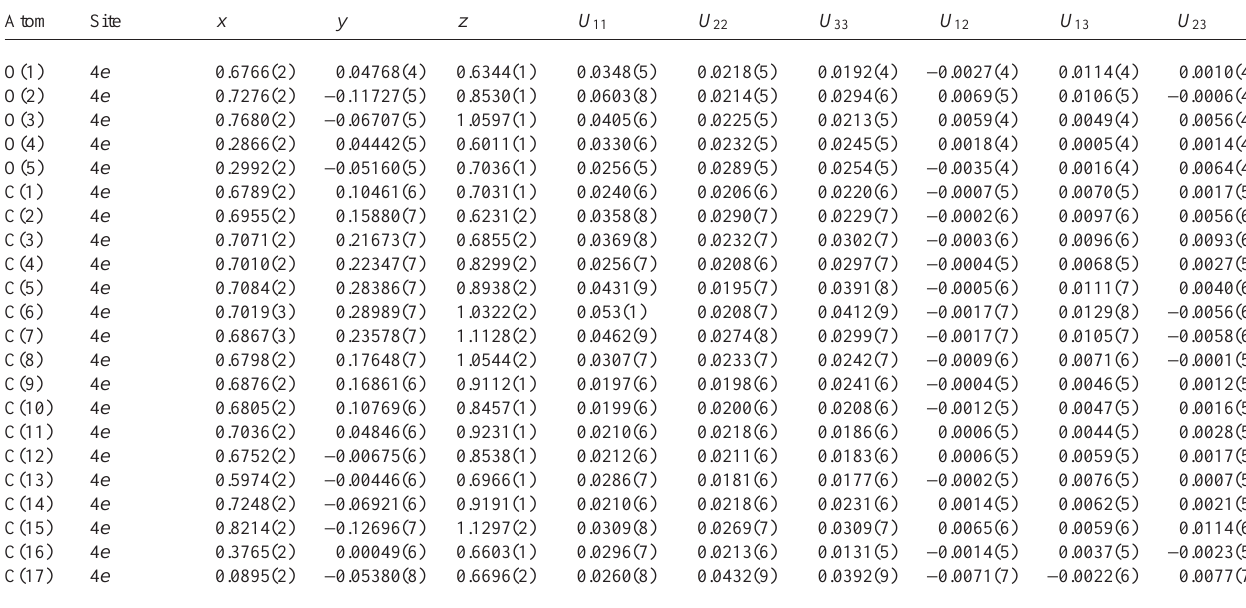
Table 3. Atomic coordinates and displacement parameters (in Å 2 )